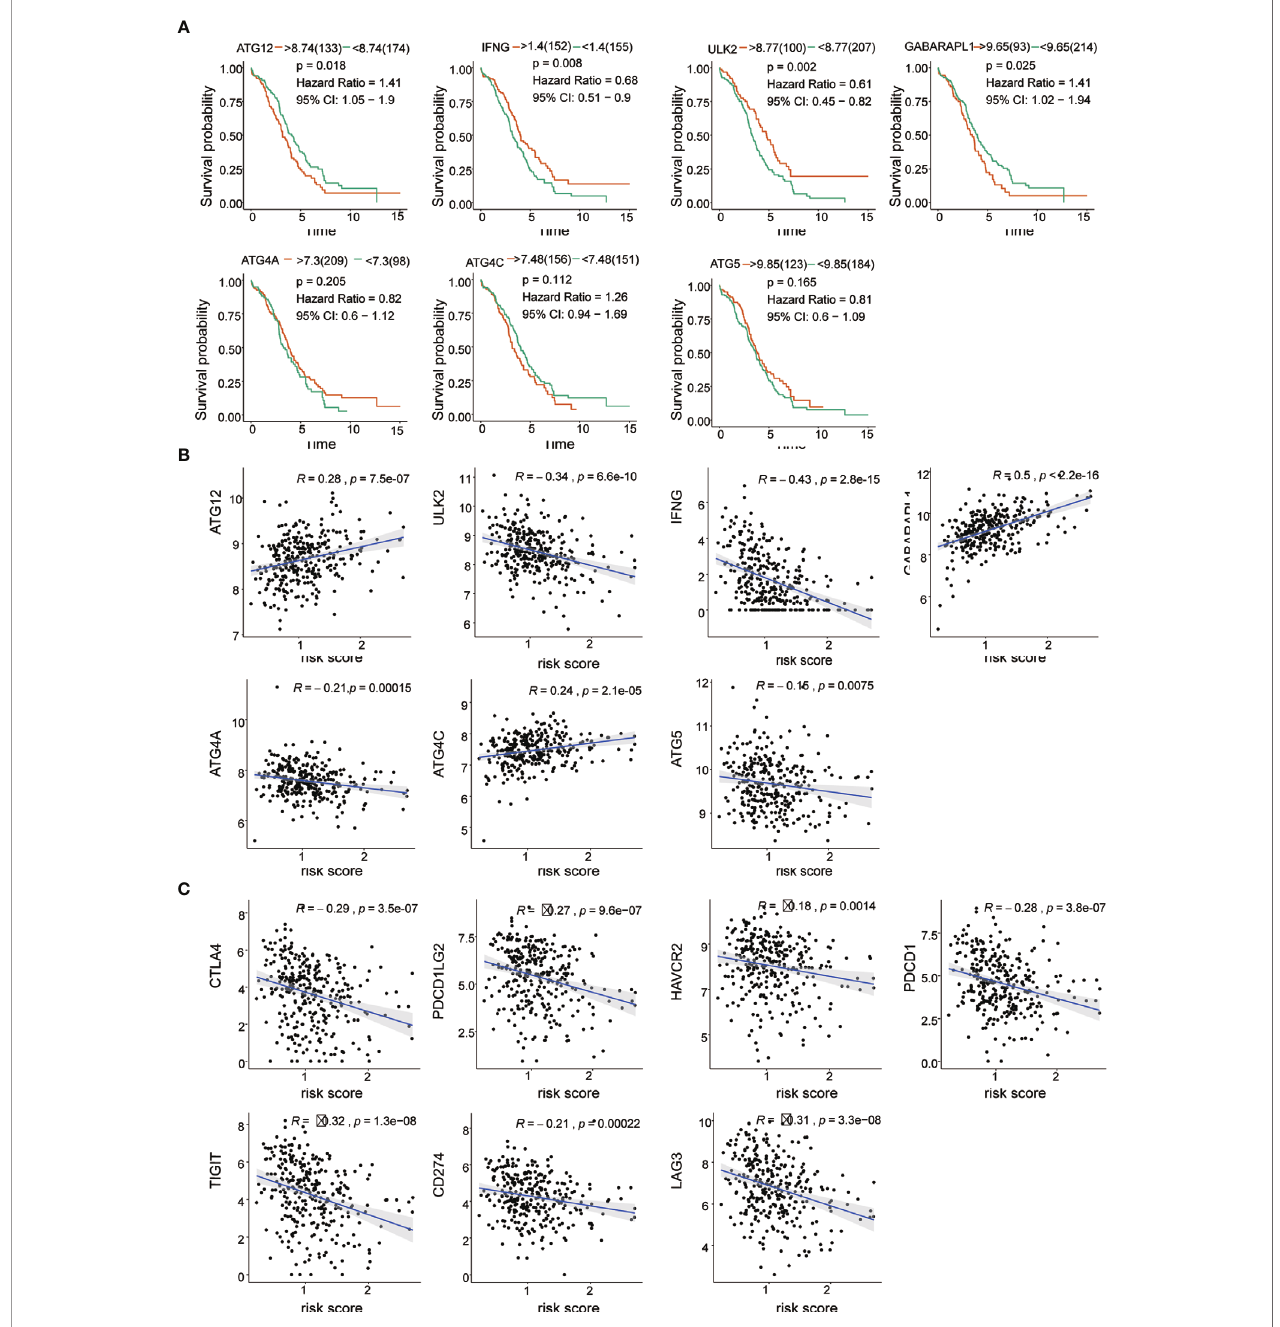
FIGURE 6 | Correlation of risk score with 7 ARG signatures and important immune checkpoints. (A) Kaplan-Meier survival analysis of the 7 ARGs in the TCGA-OV cohort. (B) Correlation between risk score and 7 ARGs. (C) Correlation between risk score and immune